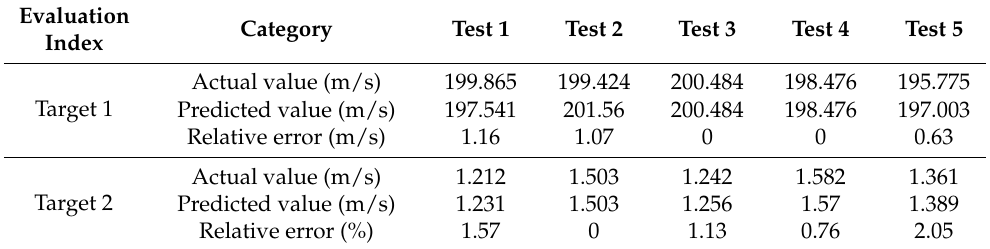
Figure 10. Error analysis between actual value and prediction value. Table 9. Error between actual value and predicted value of BP neural network.